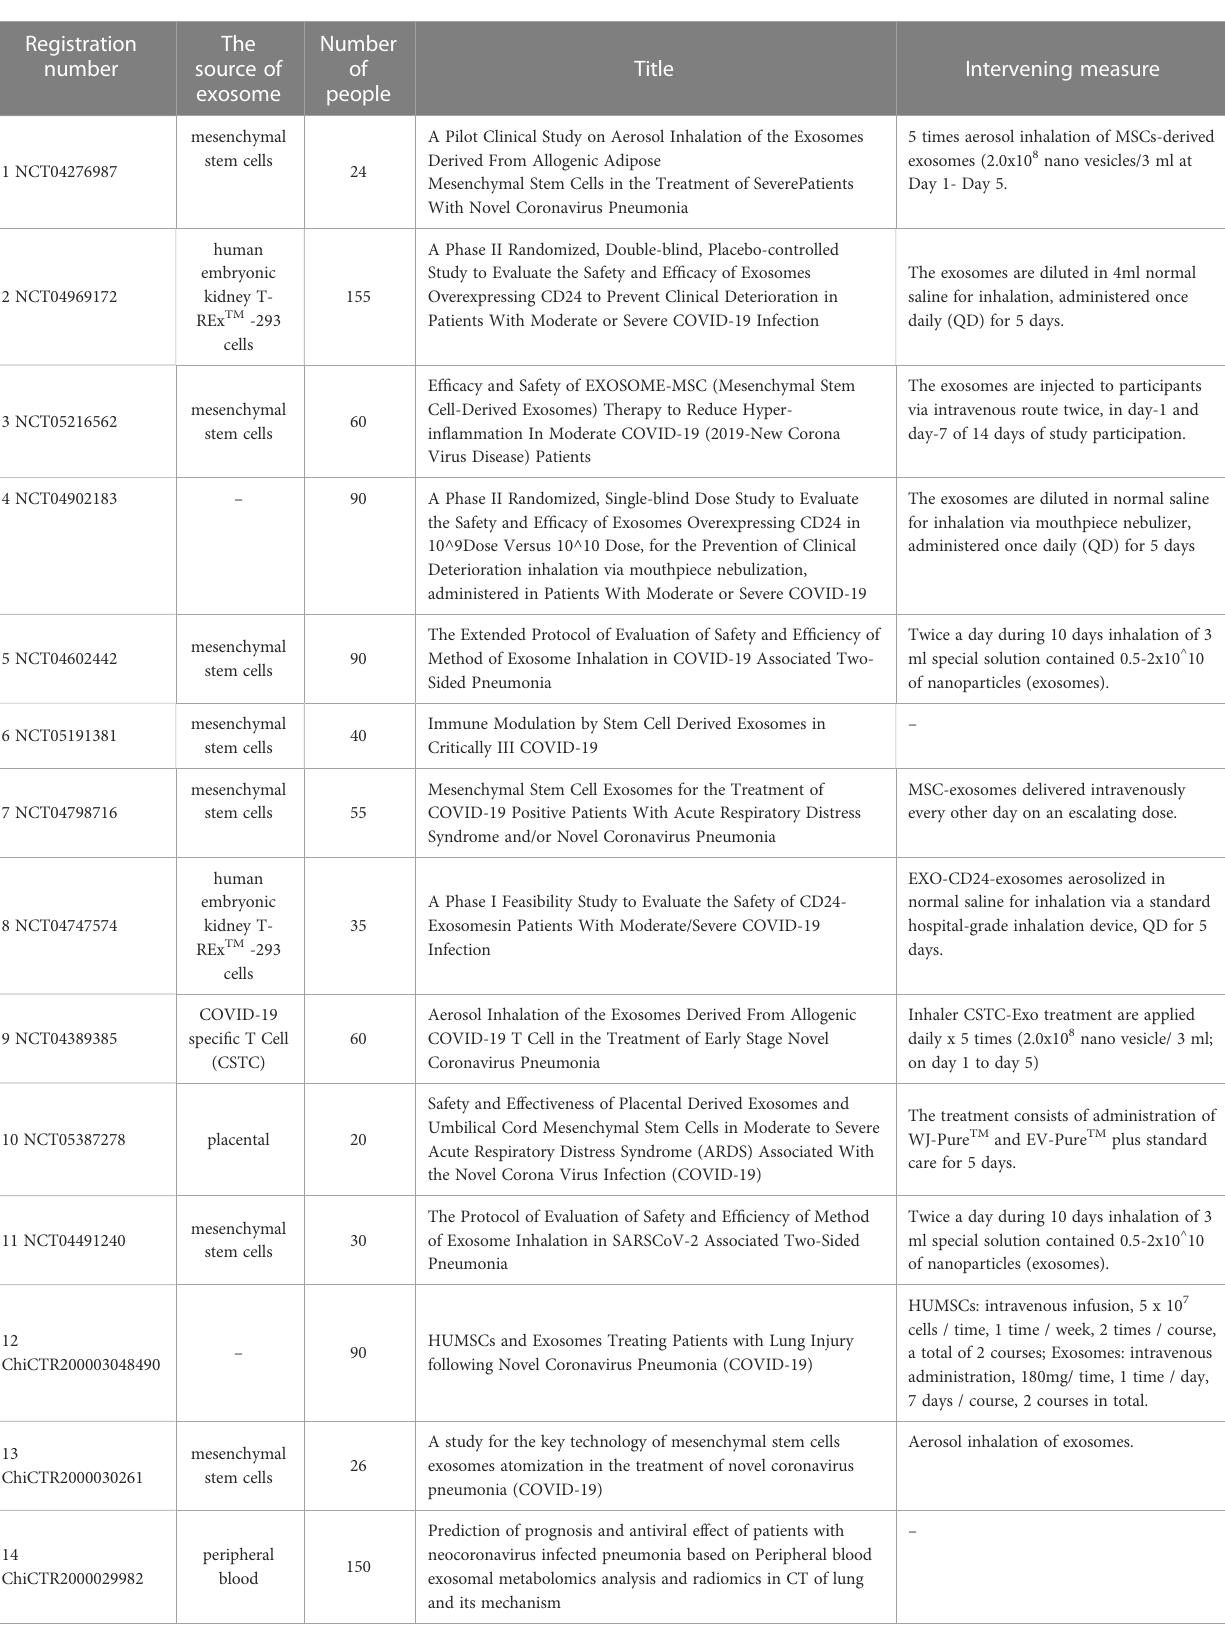
TABLE 1 Clinical trials of exosomes and